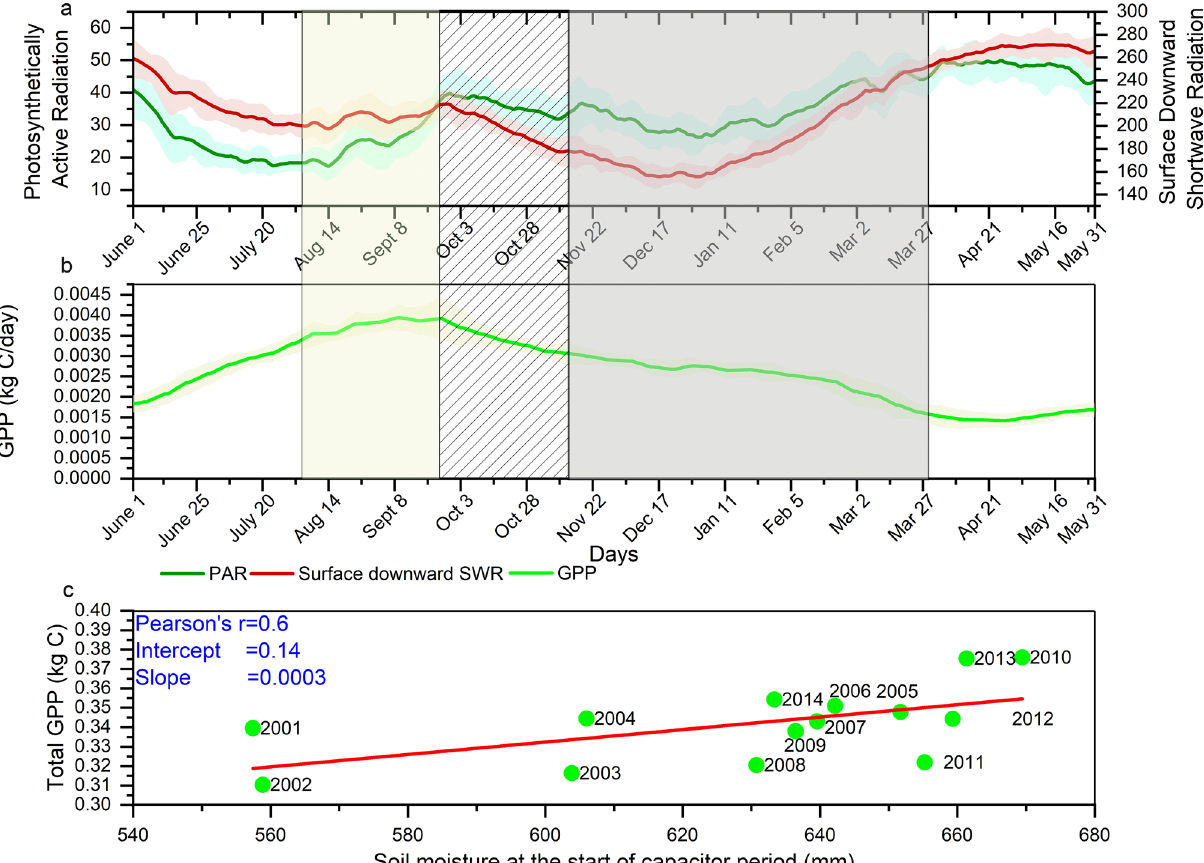
Figure 4. ( a ) Climatology of Photosynthetically Active Radiation (PAR) and downward surface Shortwave Radiation (surface SWR) for 2001 to 2015. ( b ) Climatology of GPP for 2001 to 2015. The shaded yellow, hatched and grey regions correspond to the delayed response period, pre-capacitor period and capacitor period, respectively. ( c ) Association between soil moisture at the beginning of the capacitor period and total GPP generated during the period. A linear correlation of 0.57 (statistically significant at p = 0.05) is observed between the two variables. The plots are prepared in Origin